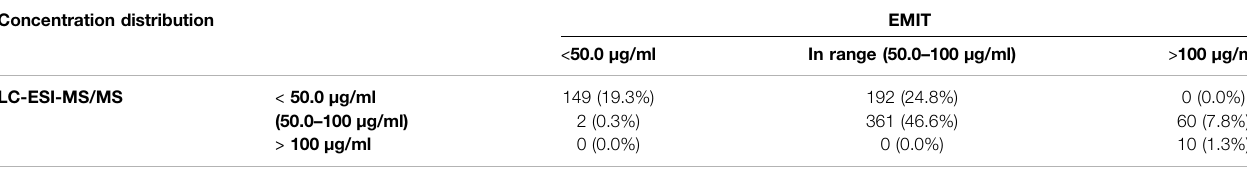
TABLE 2| The distribution oftheplasma VPA concentration data(number/percentage; n (cid:2) 774), measured byboth EMITand LC-ESI-MS/MS methods, insub-therapeutic, therapeutic, and over-therapeutic reference ranges in relation to clinical ef fi cacy of VPA for epilepsy treatment. Concentration distribution